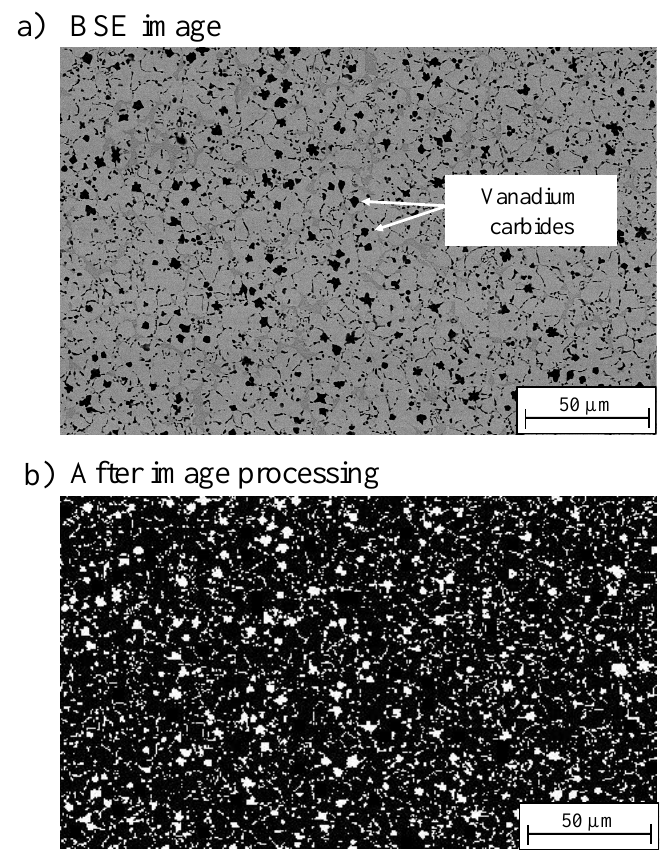
Figure 3. Backscatter electron detector (BSE) images of the microstructure ( a ) before and ( b ) after image processing.